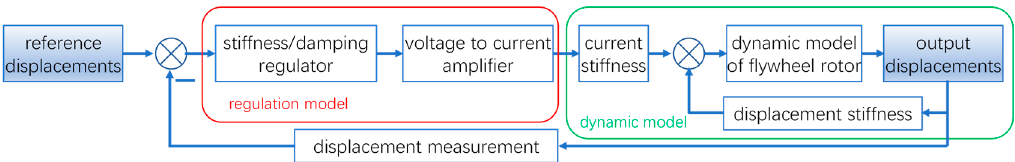
Figure 4. The feedback model used in the displacement control of the 5 ‐ DoF MSMW.